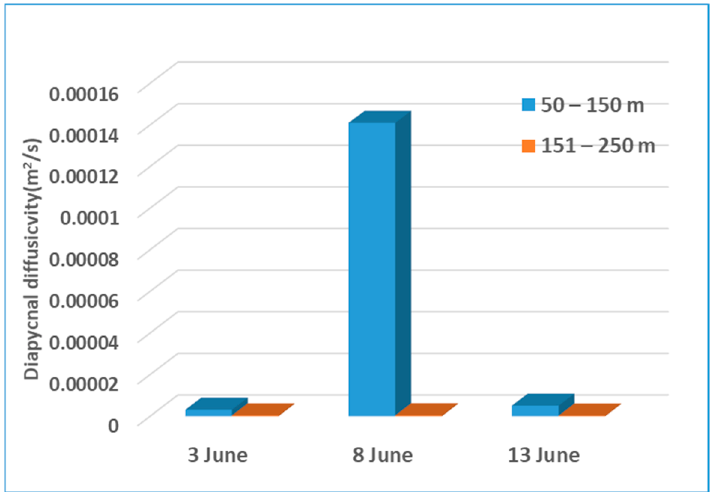
Figure 15. Calculated diapycnal diffusivity at Argo float 2900556 for 3, 8, and 13 June 2007.